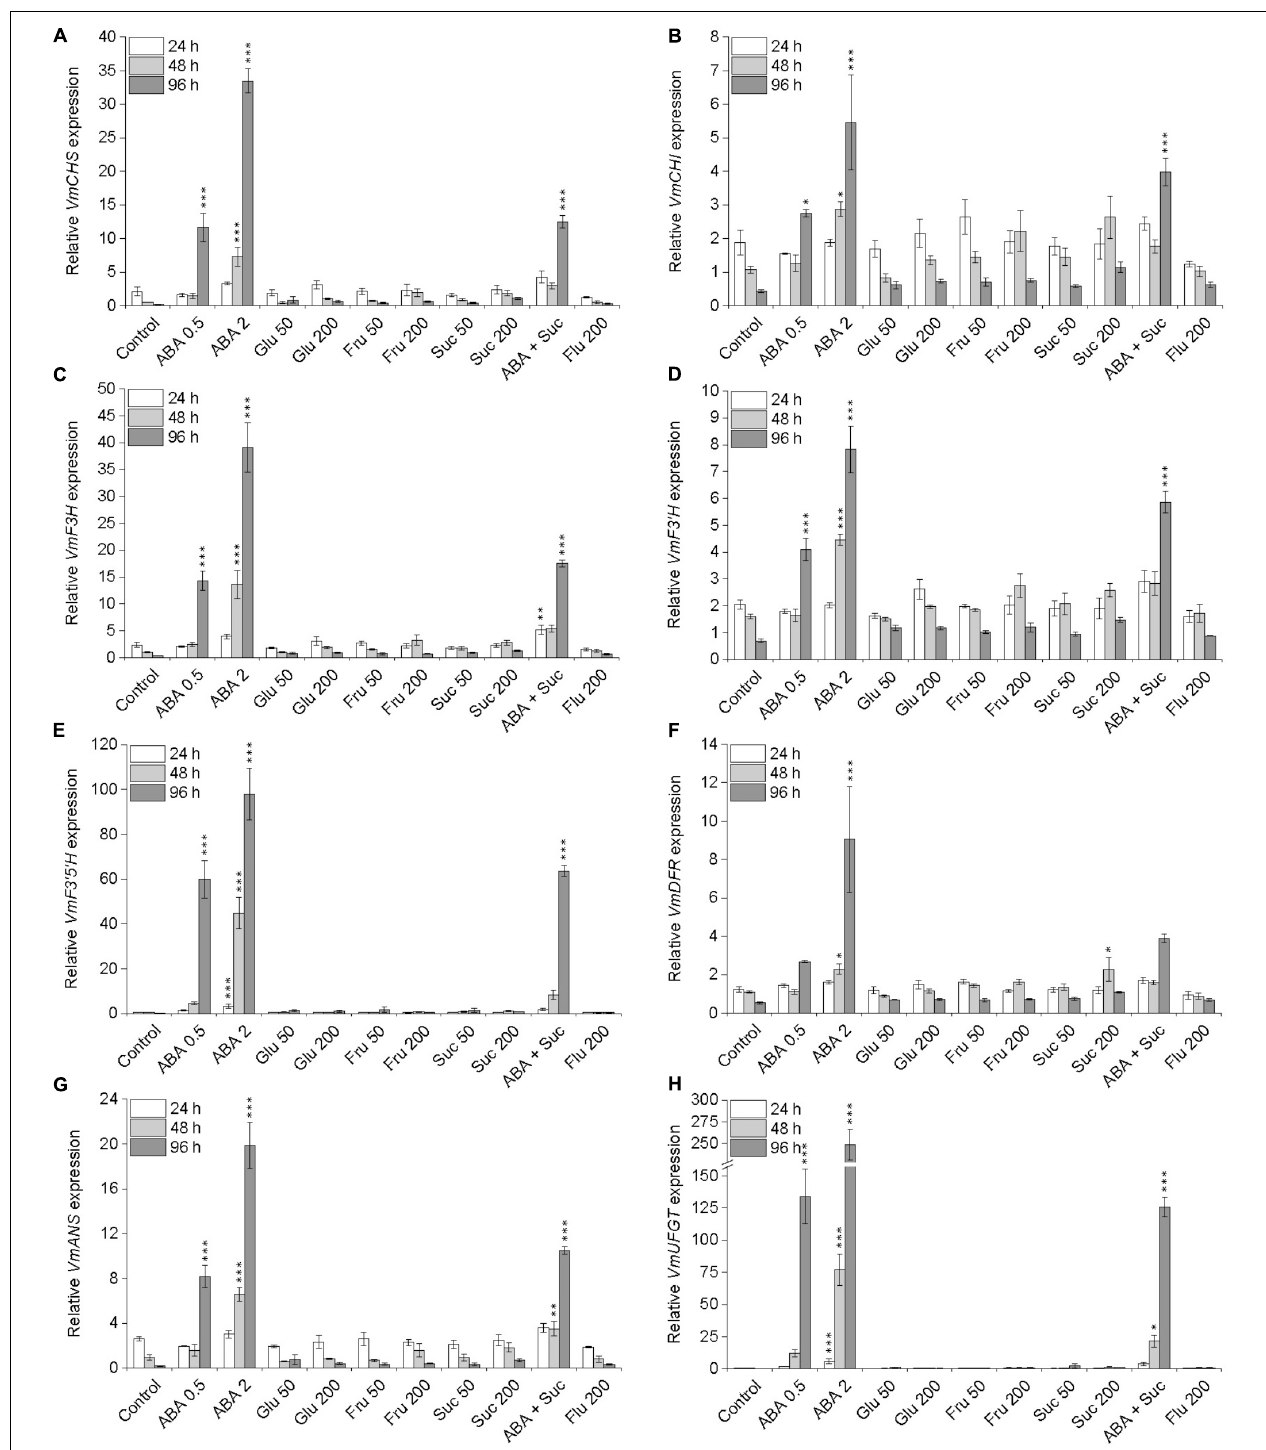
FIGURE 4 | Effect of post-harvest ABA and sugar treatments on the expression of anthocyanin biosynthetic genes VmCHS (A) , VmCHI (B) , VmF3H (C) , VmF3 (cid:48) H (D) , VmF3 (cid:48) 5 (cid:48) H (E) , VmDFR (F) , VmANS (G) , and VmUFGT (H) in bilberry fruit. The treatments were: ABA (0.5 and 2 mM), glucose (50 and 200 mM), fructose (50 and 200 mM), sucrose (50 and 200 mM), 0.5 mM ABA + 200 mM sucrose, 200 µ M fluridone or water (control). Relative expression of the genes was quantified by qRT-PCR and normalized to VmGAPDH . Values represent means ± SEs of three replicates. Asterisks indicate significant differences from respective control ( ∗ P ≤ 0.05, ∗∗ P ≤ 0.01, ∗∗∗ P ≤ 0.001, one-way ANOVA with Tukey’s HSD test).